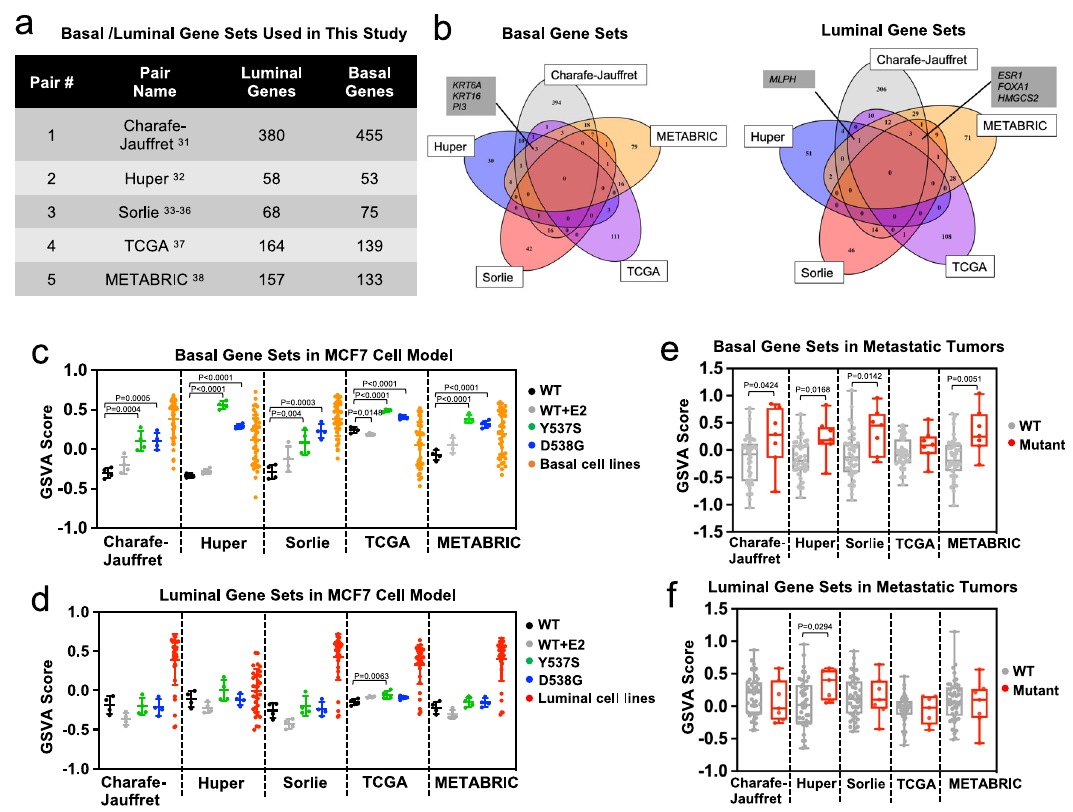
Fig. 1 Basal breast cancer gene sets are enriched in ESR1 mutant breast cancers. a Five pairs of luminal/basal gene sets applied in this study with gene numbers speci fi ed in each set. b Venn diagram representing the overlap of genes from the basal (left) and luminal (right) gene sets. Genes overlapping in at least four gene sets are indicated. c , d Dot plots showing GSVA score of the fi ve pairs of basal ( c ) and luminal ( d ) gene sets enrichment in MCF7 genome-edited cell models. Four biologically independent replicates were used from the original RNA-seq data set (GSE89888) for one time computation. Scores from luminal ( n = 33) and basal ( n = 39) breast cancer cell lines were used as positive controls. Data are presented as mean ± SD. Dunnett ’ s test (two-sided) was used to compare with WT-vehicle set within each gene set. e , f Box plots representing basal ( e ) and luminal ( f ) gene set enrichments in intra-patient matched paired primary-metastatic samples. Delta GSVA score for each sample was calculated by subtracting the scores of primary tumors from the matched metastatic tumors. Box plots span the upper quartile (upper limit), median (center) and lower quartile (lower limit). Whiskers extend a maximum of 1.5× IQR. Mann – Whitney U -test (two-sided) was performed to compare the Delta GSVA scores between WT ( N = 44) or ESR1 mutation- harboring ( N = 7) paired tumors. Source data are provided as a Source Data fi le for c – f